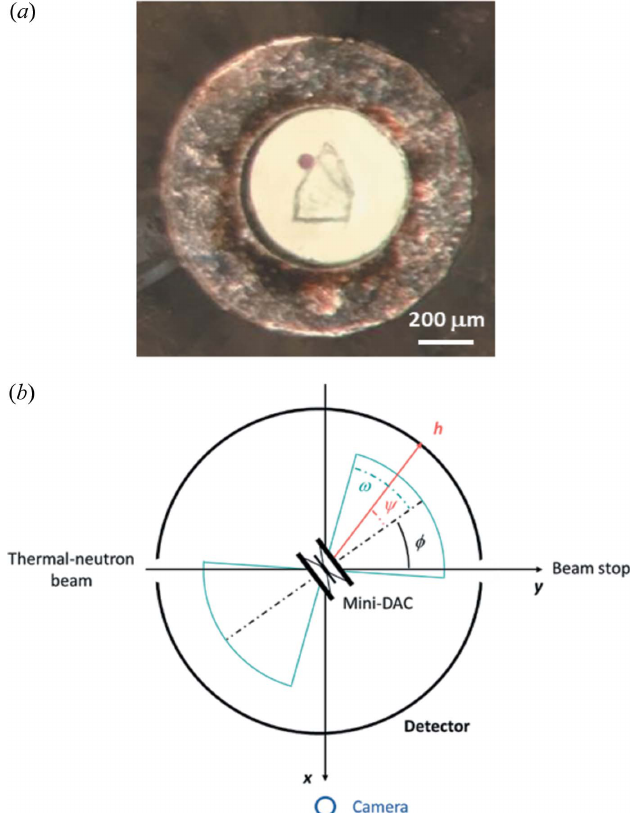
Figure 1 ( a ) Microscope photograph of the copper sulfate pentahydrate crystal with a chip of ruby in the mini-DAC gasket. ( b ) Geometry of the Koala instrument and mini-DAC view along the z axis, the latter being enlarged to show the geometry. The angle which the scattered ray, h , makes with the cell axis is denoted